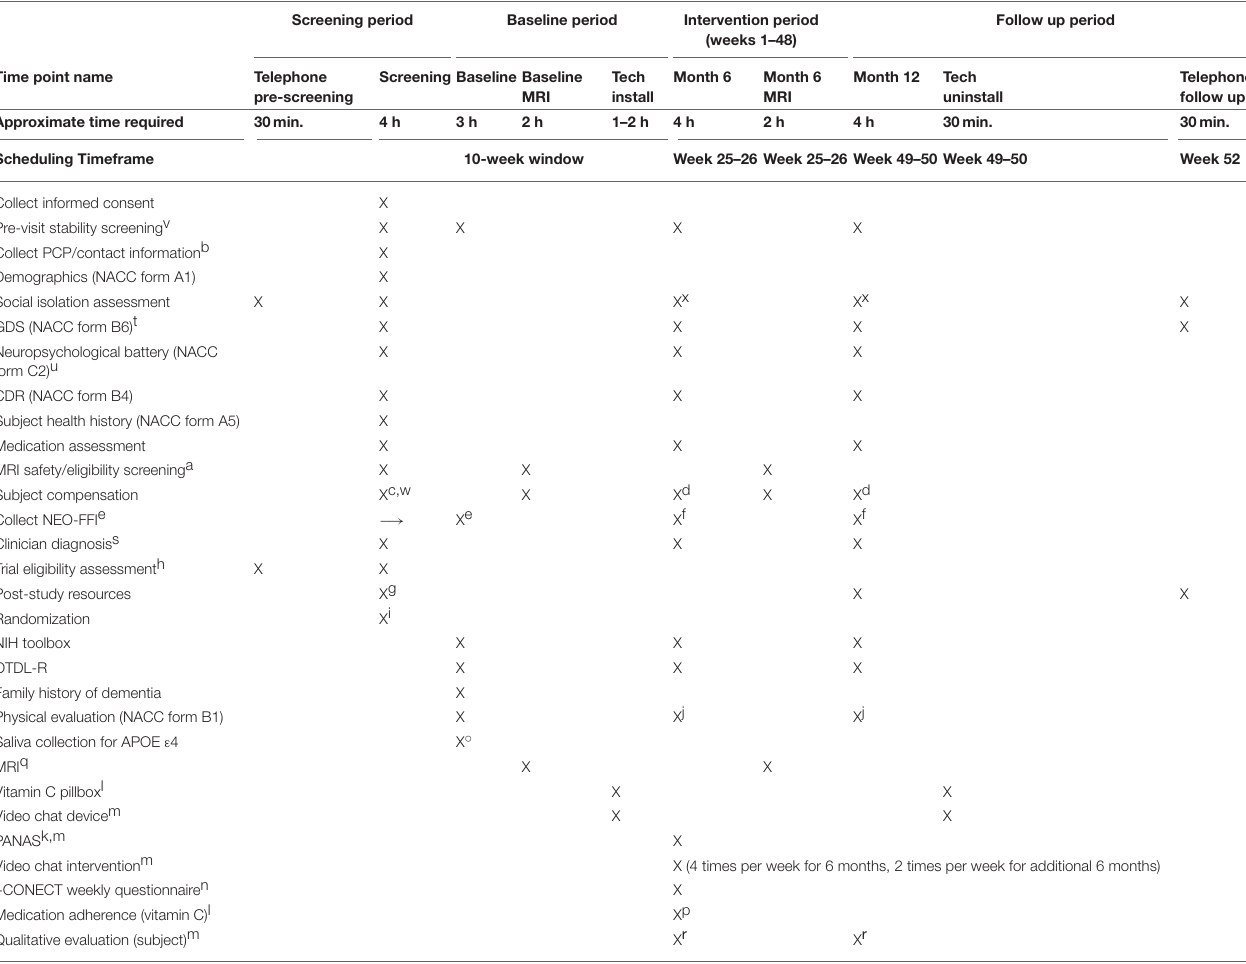
TABLE 3 | Assessment